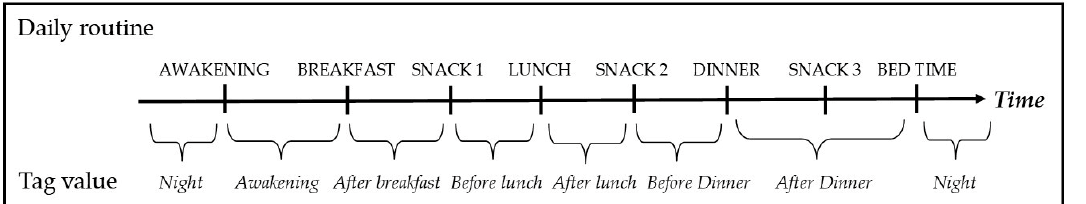
Figure 3. Assigning the profile tag to BG events. The tag value (bottom) is assigned by comparing the time of occurrence of the considered event to the usual time of the patient’s daily activities (top).